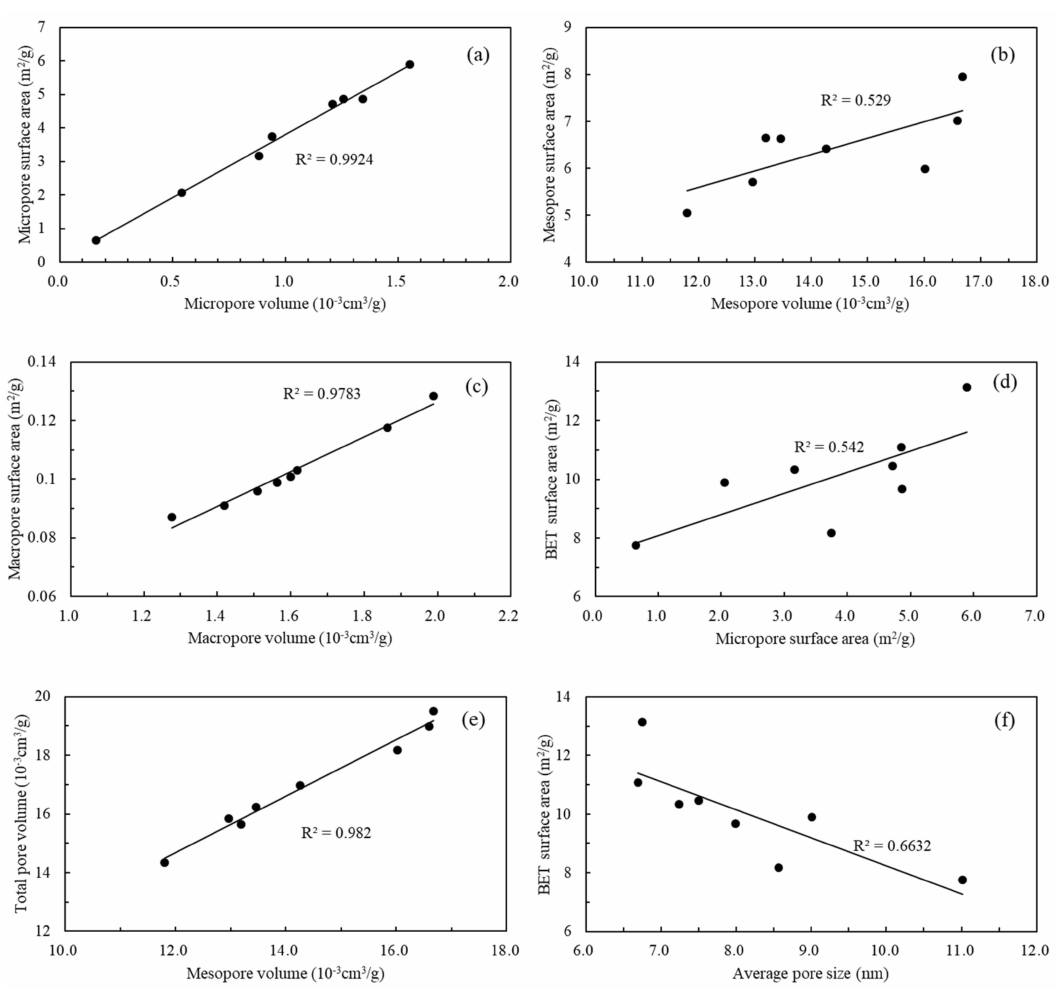
Figure 6. Relationships between SA and PV (( a ), micropore; ( b ), mesopore; ( c ), macropore), relationship between micropore SA and BET SA ( d ), relationship between mesopore volume and total pore volume ( e ), and relationship between APS and SA ( f